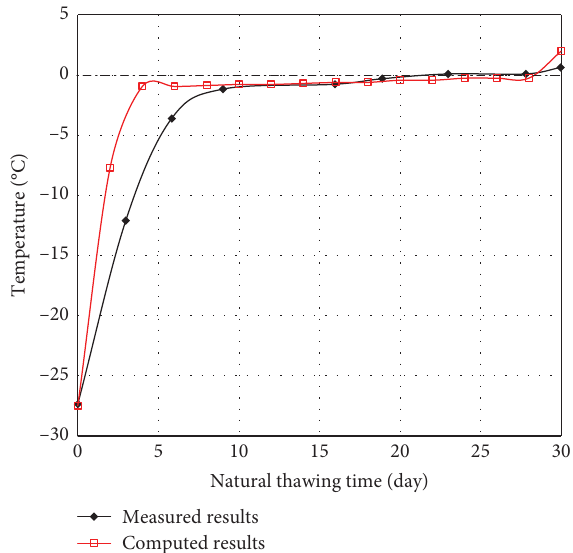
Figure 4: Comparison of measured and computed results of temperature-thawing time